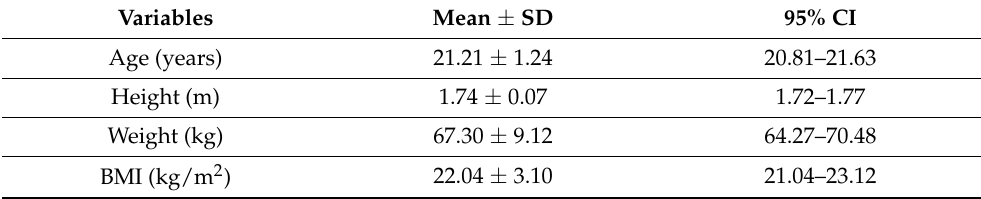
Table 1. Characteristics and demographic data of participants ( n = 33).